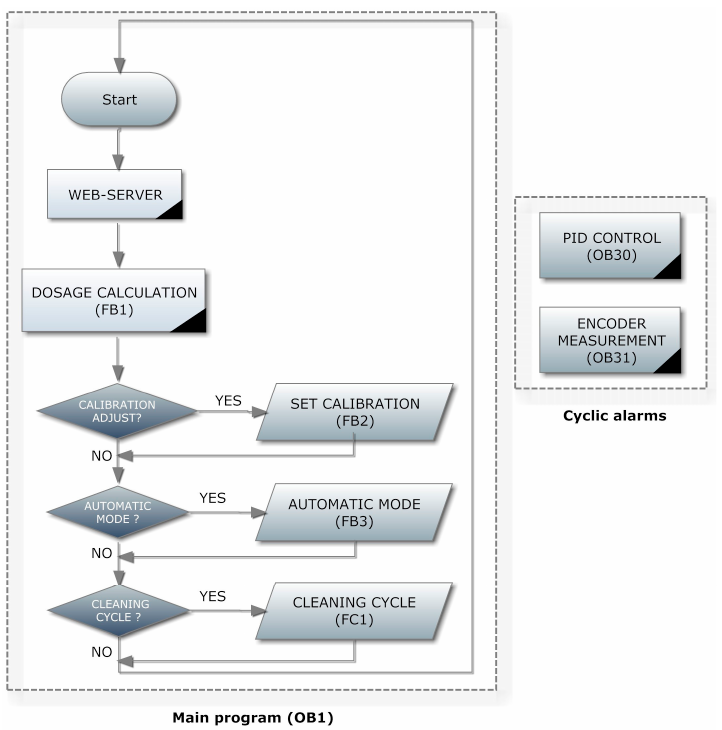
Figure 3. Flowchart of the program of the PLC.